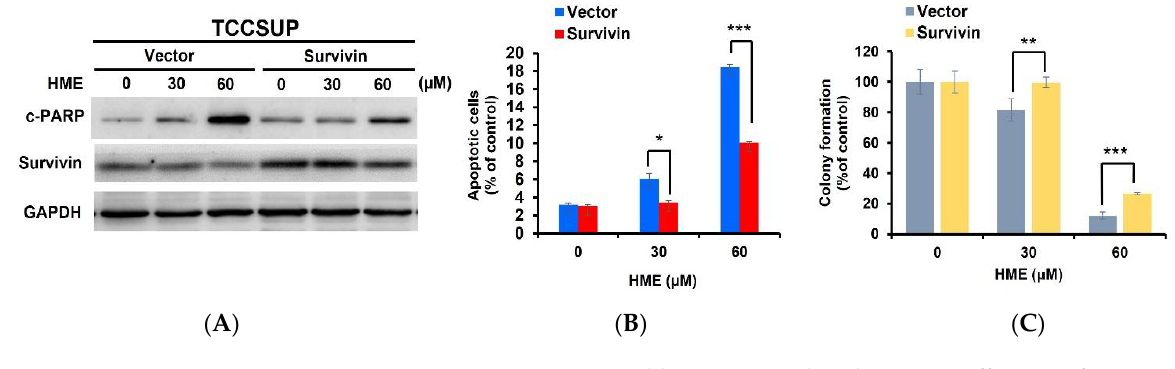
Figure 4. Ectopic survivin expression blunts HME-induced cytotoxic effects, confirming survivin downregulation as a pivotal mechanism of HME’s anti-bladder cancer action. TCCSUP stable clones of survivin and the respective vector controls were subjected to 24 h-treatment with HME (0, 30, 60 µ M) and then subjected to immunoblotting for c-PARP, survivin, and GAPDH (loading control)